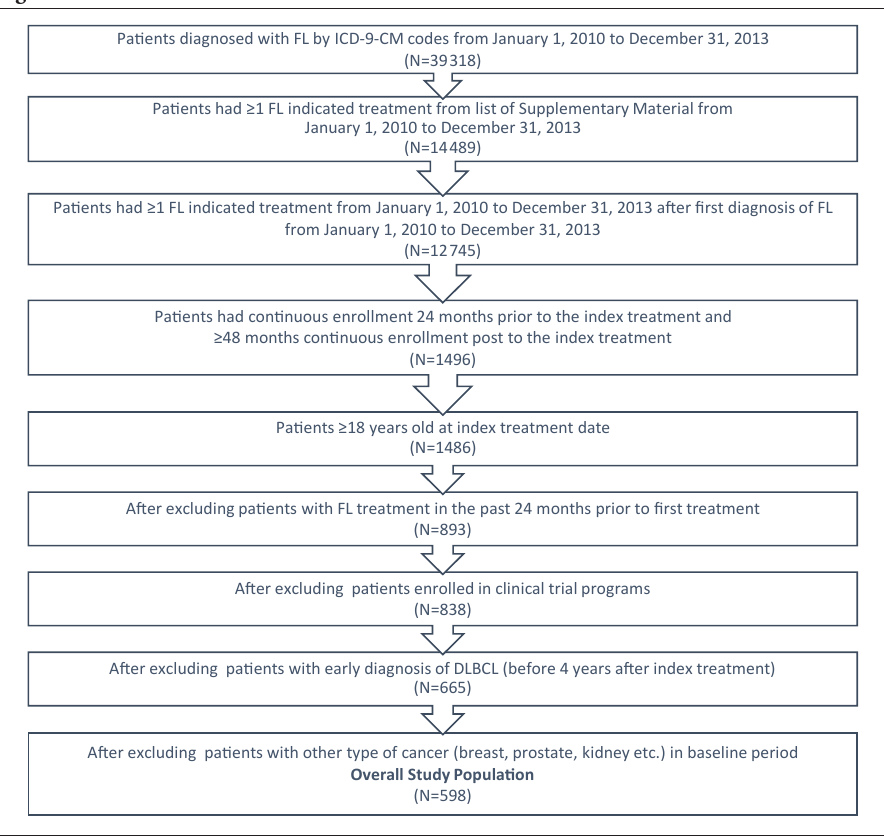
Figure 1. Patient